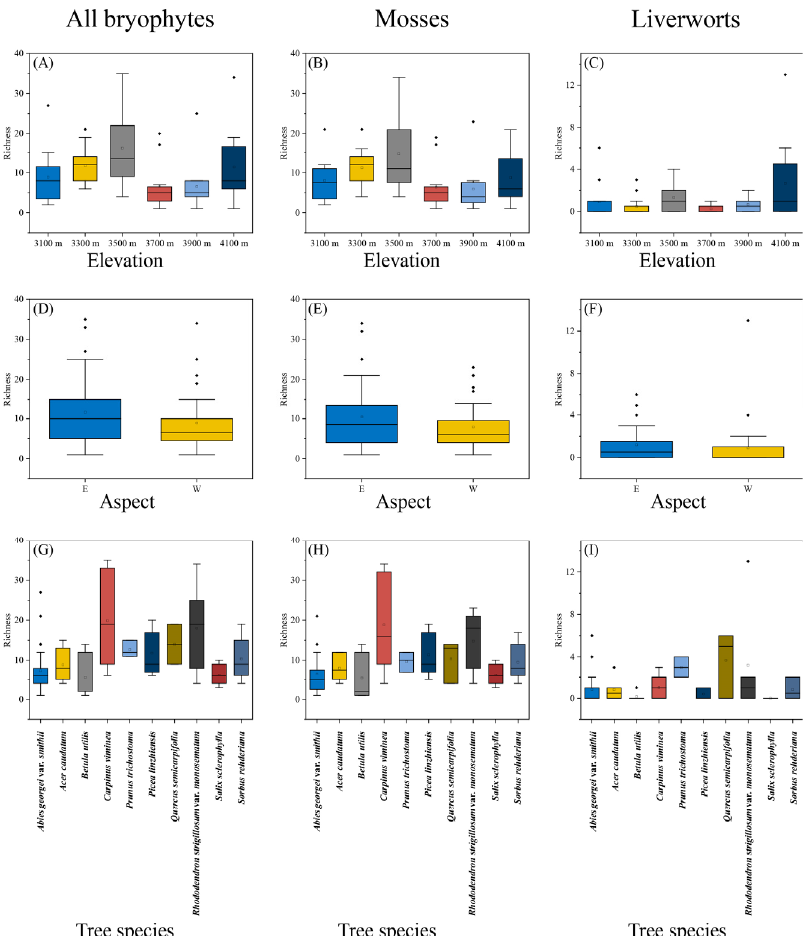
Figure 2. The diversity differences among different elevations, aspect, tree species. ( A – C ) elevation; ( D – F ) aspect; ( G – I ) tree species. Different lines represent the environmental conditions: elevation, aspect, tree species. Different columns represent type: all bryophytes, mosses, and liverworts. Lowercase letters indicate significant differences at 0.05 error probability levels among different elevations, aspect, tree species. The boxes represent the range of values between the third and the first quartile. Outliers are values that do not fall within 1.5 times the interquartile range of the first and third quartiles (indicated by the whiskers). In each box, the horizontal black line represents the median while the mean value is represented by the hollow point.